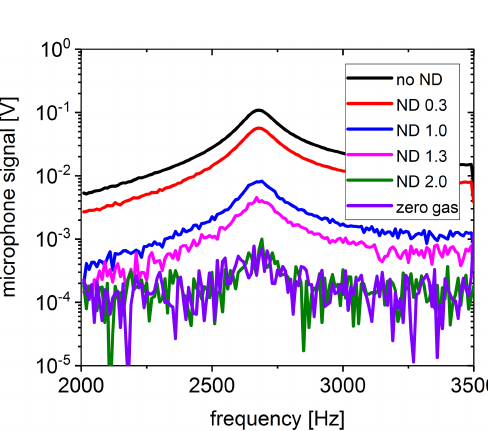
Figure 6. Acoustic resonance spectra for 10ppm CH 4 in the PAS cell. The QCL intensity was changed using neutral density (ND) filters. The zero-gas spectrum was obtained with no